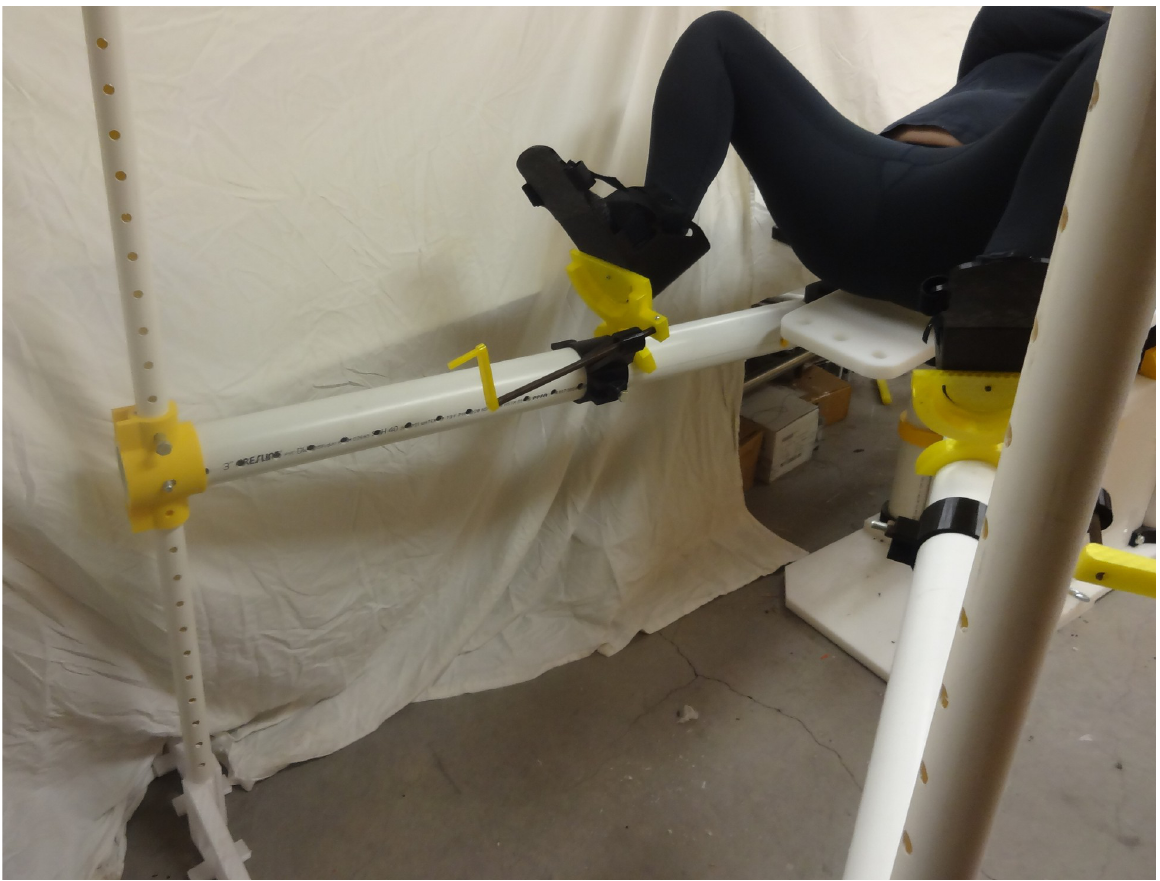
Fig 33. Table tilted down and both legs bent with no